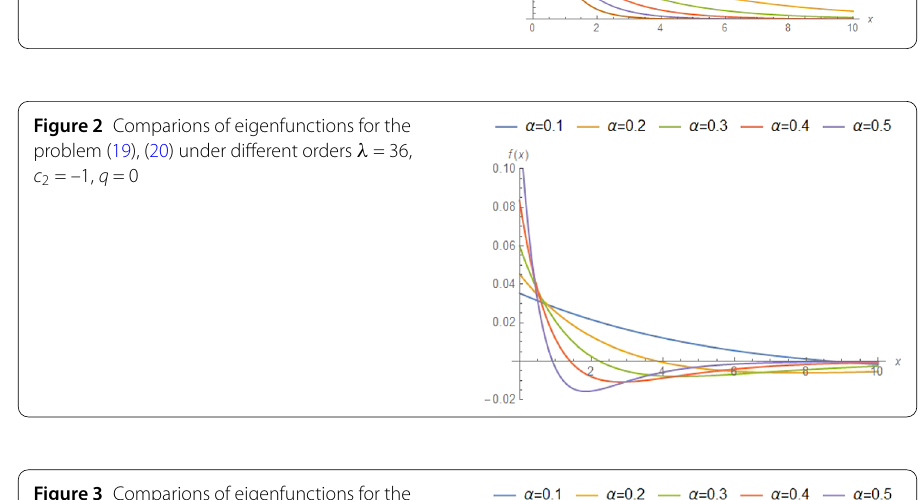
Figure 3 Comparions of eigenfunctions for the problem (16), (17) under different orders λ = 36, c 1 = c 2 = –1, q =